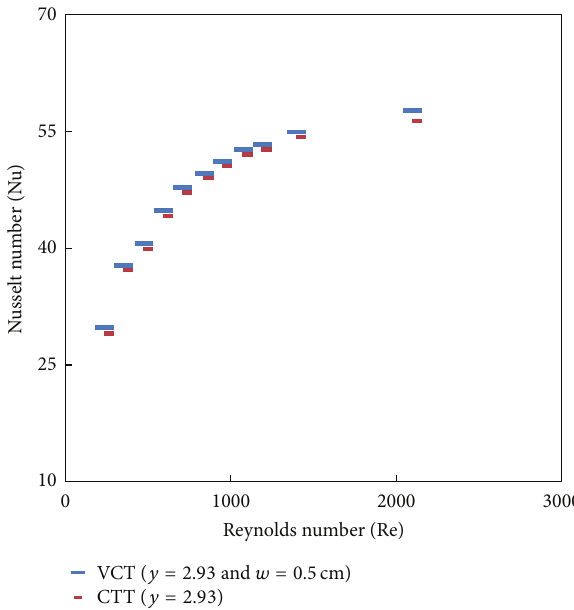
Figure 10: Simulated Nusselt number of classical and V-cut twisted tape inserts ( 𝑦 = 2.93 ) with cut depth 𝑤 = 0.5